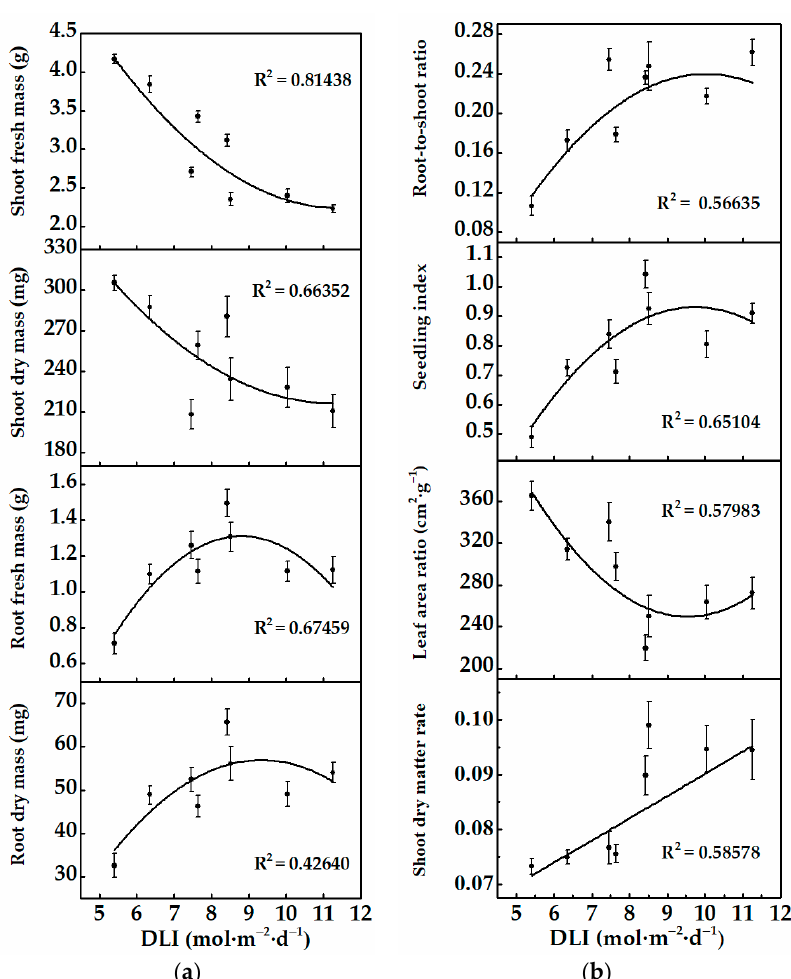
Figure 3. Relationships between DLI and ( a ) shoot fresh and dry mass, root fresh and dry mass, ( b ) root-to-shoot ratio, seedling index, leaf area ratio, and shoot dry matter rate of cucumber seedlings. Each symbol represents the mean of 18 plants in each treatment, and error bars represent SEs of means. Fitting formula shown in supplementary section.